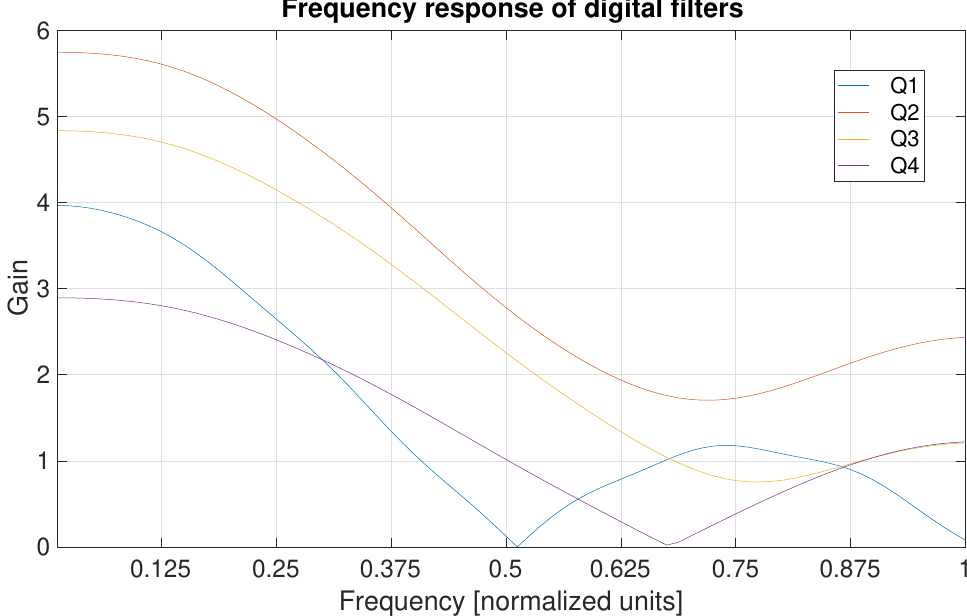
Figure 4. Frequency responses of the 4 digital filters that are used to perform the data fusion. All filters are characterized by 2 L = 16